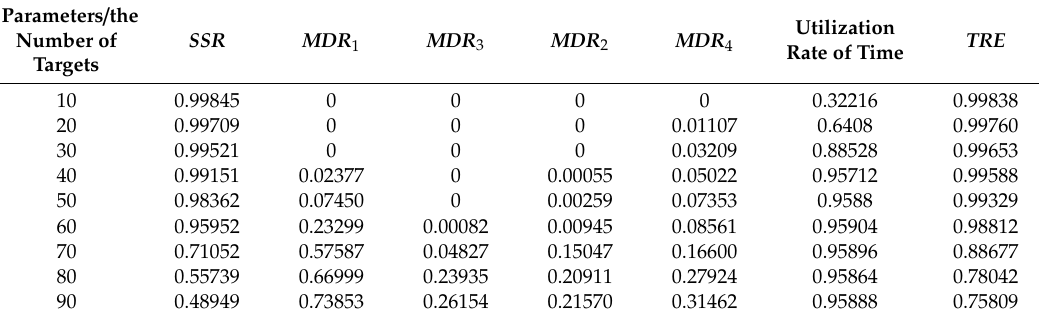
Table 4. Performance parameters of THiPrEDF.